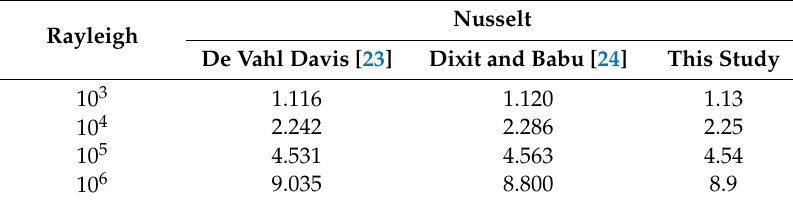
Table 4. Comparison of current study with